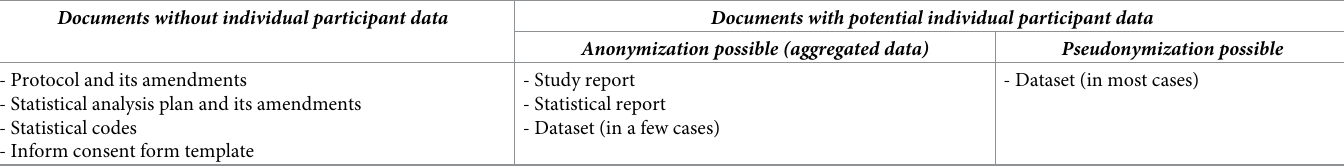
Table 1. The most important documents to be